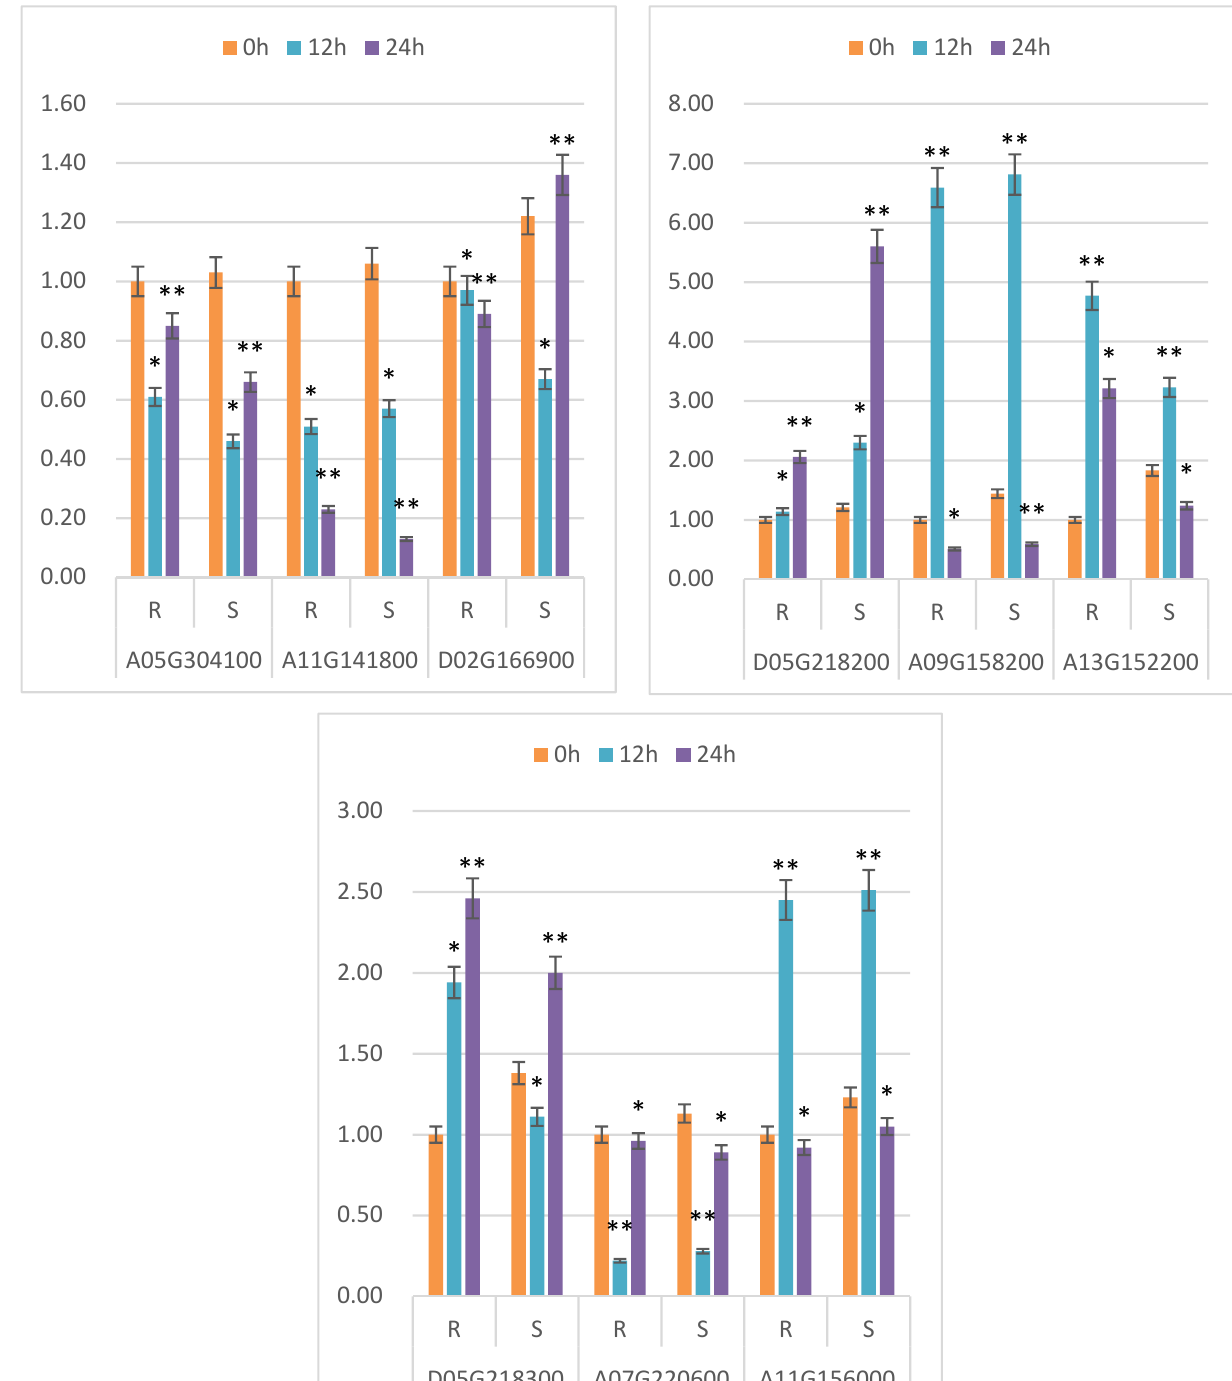
Figure 6. qRT-PCR validation of differentially expressed genes. Note: 0 h, 12 h and 24 h indicate different treatment times; R represents the drought-resistant material; S represents sensitive material; abscissa represents different genes; and ordinate represents the relative expression of genes between different materials. Transcriptome expression: under the accession number PRJNA769509, which is publicly accessible at https://www.ncbi.nlm.nih.gov/ (accessed on 1 January 2021) * and ** indicate significant differences at the 0.05 and 0.01 level, respectively.